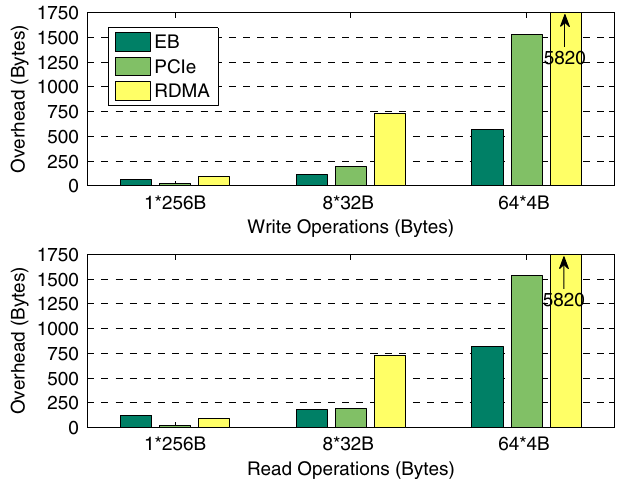
FIG. 10. Overhead of EB, PCIe, and RDMAwhen transmitting 256 Bytes read and write operations, 32 Bit word width. EtherBone distinctly excels in random access operations and block